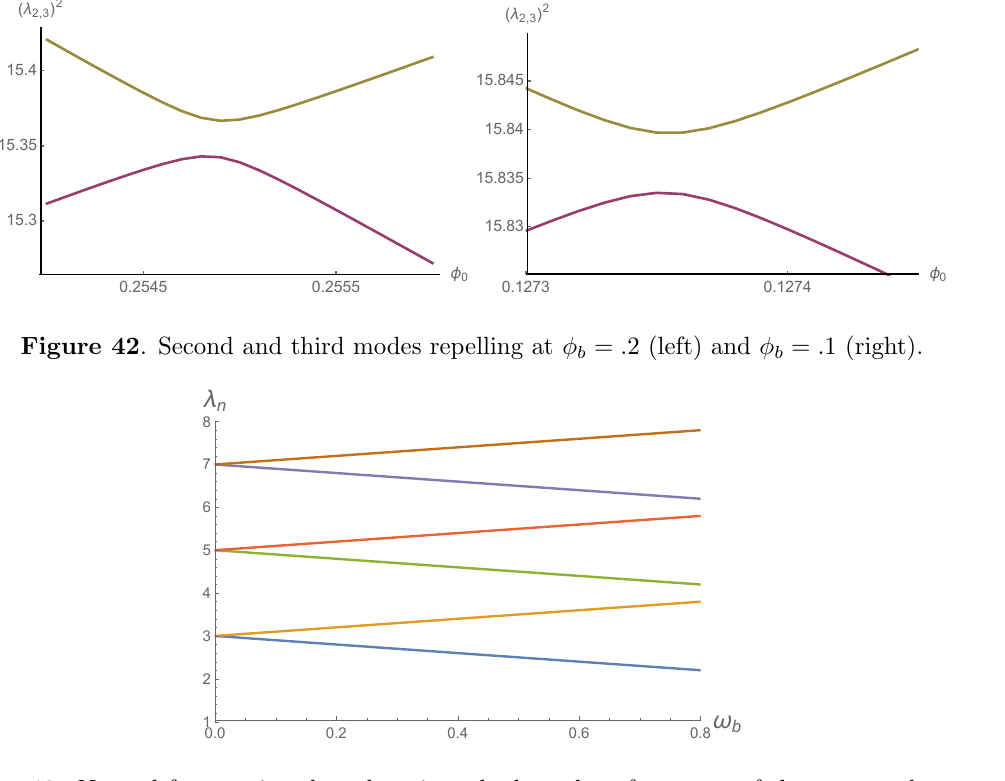
Figure 43 . Normal frequencies plotted against the boundary frequency of the source whose am- plitude is (cid:30) b = :